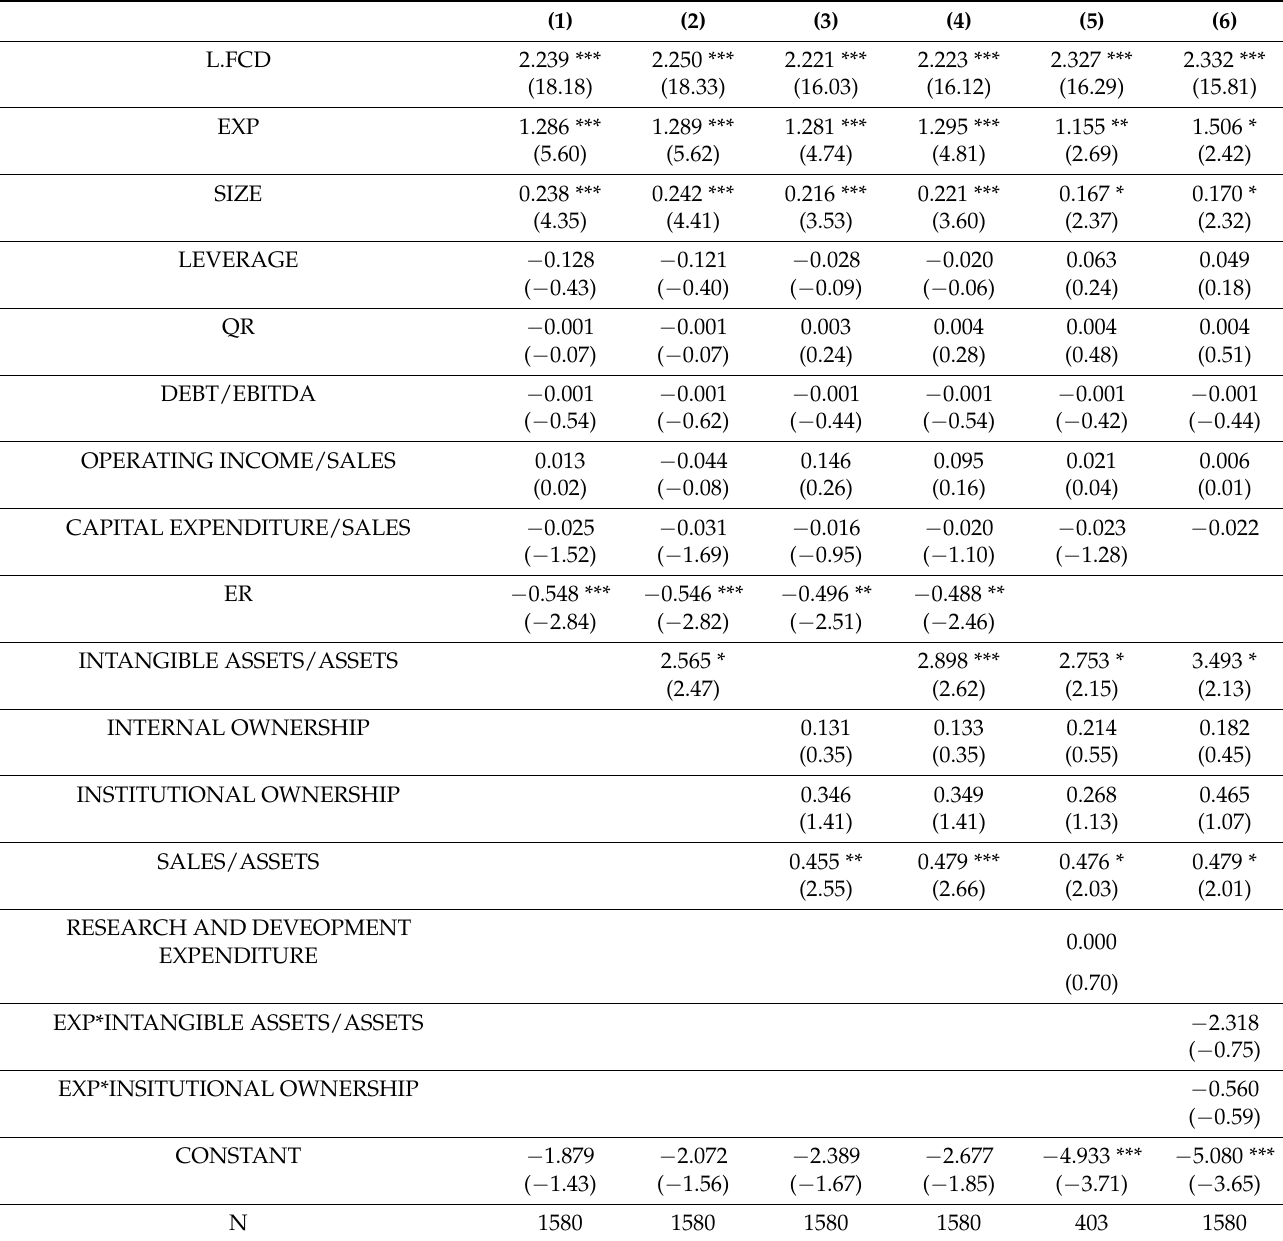
Table 7. Robustness tests for the dynamic